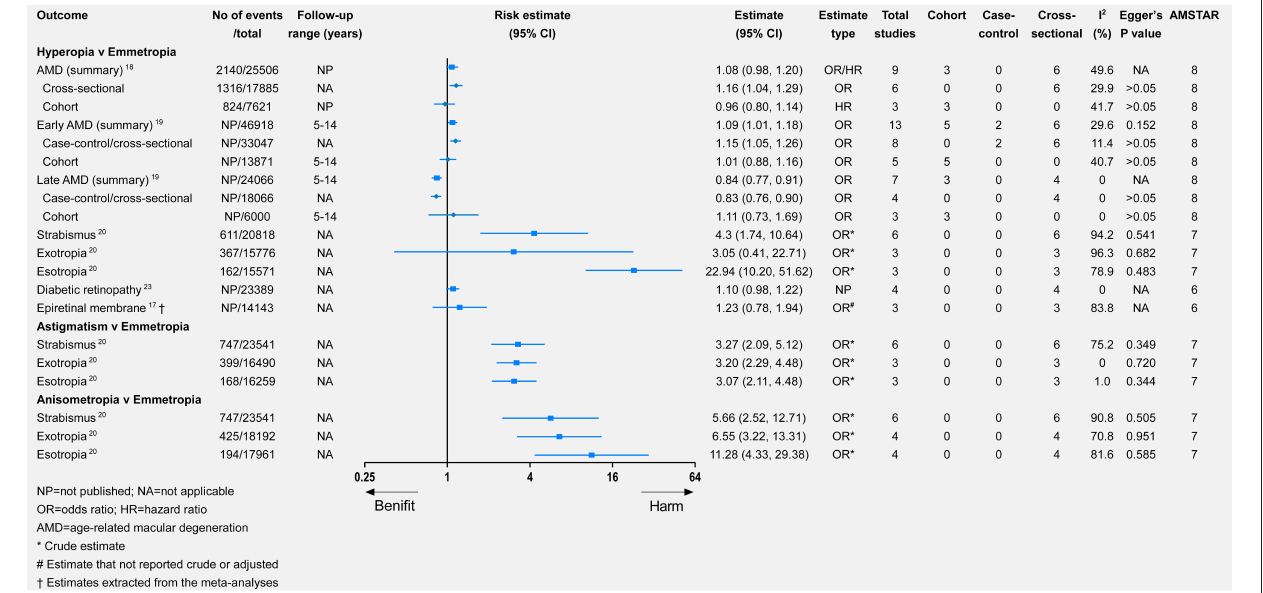
FIGURE 5 | Associations of hyperopia, astigmatism, and anisometropia with multiple eye health